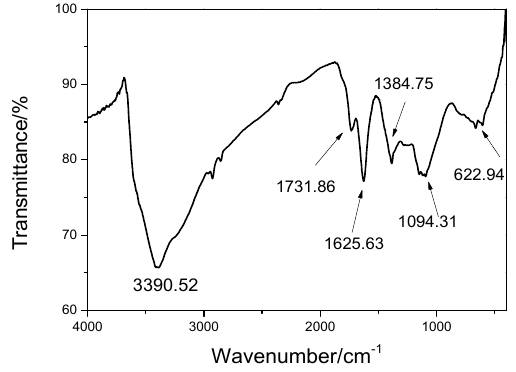
Figure 1. Fourier-transform infrared spectroscopic (FT-IR) spectrum of GO.